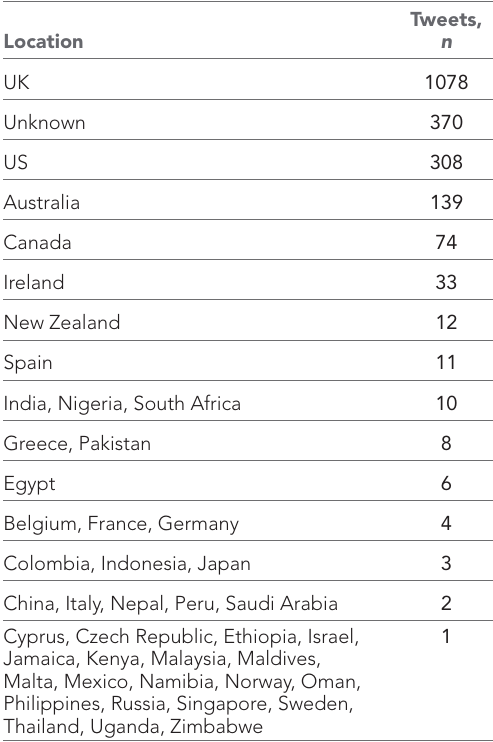
Table 2 Summary of tweet origins by